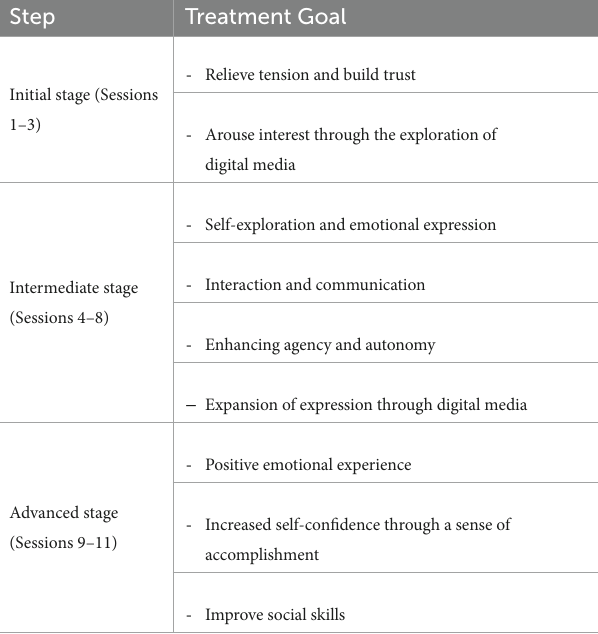
TABLE 4 Step-by-step goals of the digital art therapy